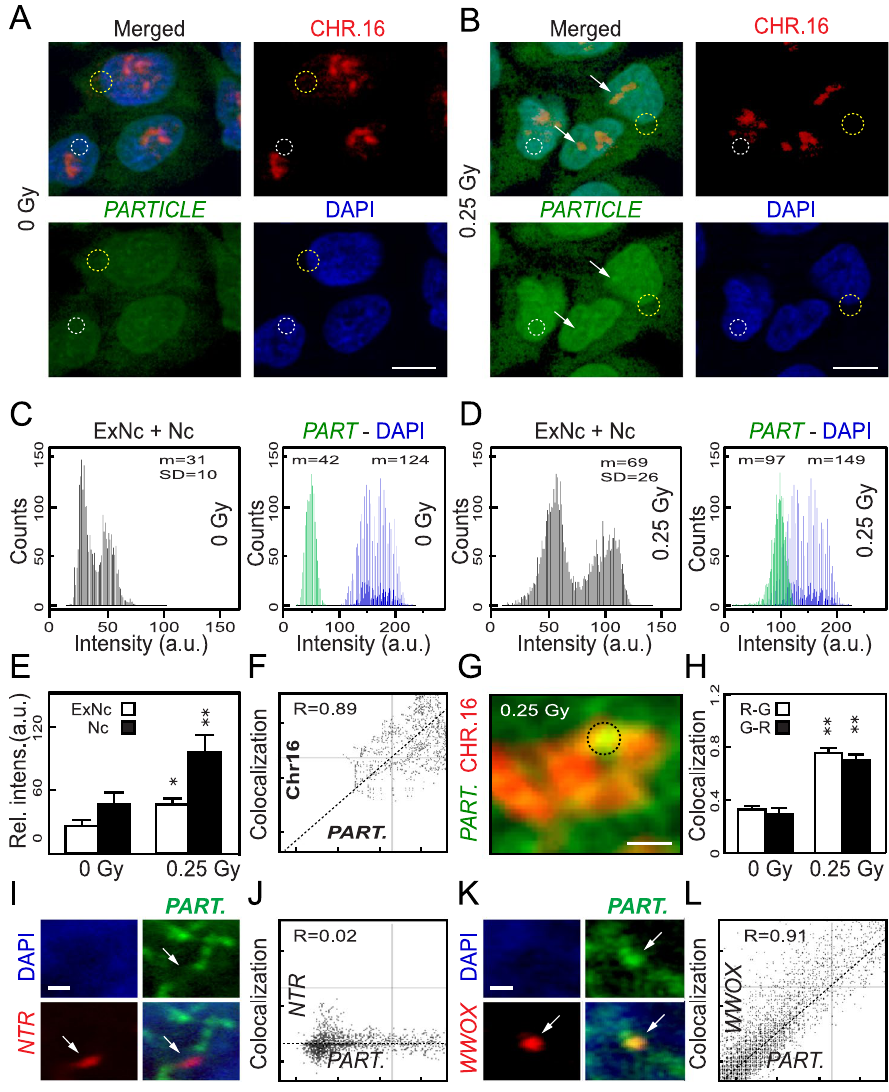
Figure 4. PARTICLE transcripts are predominantly nuclear following irradiation and associated with chromosome 16 harbouring WWOX . ( A , B ) Representative epifluorescence microscopic images of U2OS sham irradiated (left) or 24 hr post 0.25 Gy (right) labelled with chromosome 16 paint (red: upper) and RNA in-situ hybridisation probes specific for PARTICLE (green: lower). Nuclei stained with DAPI (blue; lower) with merged images (upper). Mean fluorescence intensity analysis determined from regions-of-interest (ROI) indicated by circular dashed lines. Increased intensity over chromosome 16 indicated by arrows. ( C , D ) Plots of arbitrary units (AU) of overall PARTICLE ( PART .) fluorescence intensity in the extra-nuclear (ExNc) plus nuclear (Nc) compartments (left) and intracellular distribution (right; green and blue lines represent PARTICLE and nuclear fluorescence respectively) in sham-irradiated ( C ) or 24 hr post 0.25 Gy ( D ). ( E ) Summary plots illustrating average relative fluorescence intensities pooled from the selected ROIs from the various experimental groups. ( F ) Scatterplot of arbitrary units (AU) of PARTICLE and chromosome 16 co-localization from a ROI (dashed circle), on ( G ) a representative high resolution epifluorescence micrograph after chromosomal spreading. ( H ) Summary co-localization plots for chromosome 16 (ChR = red channel) and PARTICLE (ChG = green channel) in ROIs taken from sham irradiated (0 Gy) or 24 hr post 0.25 Gy. Data are represented as mean ± SEM. ( I ) Representative epifluorescence microscopic images of U2OS labelled with RNA in-situ hybridisation probes specific for PARTICLE ( PART : pseudo green: upper right) and dual labelled probe specific for a predicted Non-Triplex Region (NTR: pseudo red: lower left). Nuclei stained with DAPI (blue; upper left) with merged images (lower right). Arrow indicates absence of PARTICLE at NTR. ( J ) Scatterplot of arbitrary units (AU) of PARTICLE ( PART .) and NTR indicating no co-localization. ( K ) Representative epifluorescence microscopic images of U2OS labelled with RNA in-situ hybridisation probes specific for PARTICLE ( PART : pseudo green: upper right) and dual-labelled probe-specific for WWOX locus (pseudo red: lower left). Nuclei stained with DAPI (blue; upper left) with merged images (lower right). Arrow indicates presence of PARTICLE at WWOX locus. ( L ) Scatterplot of arbitrary units (AU) of PARTICLE ( PART .) and WWOX indicating strong co-